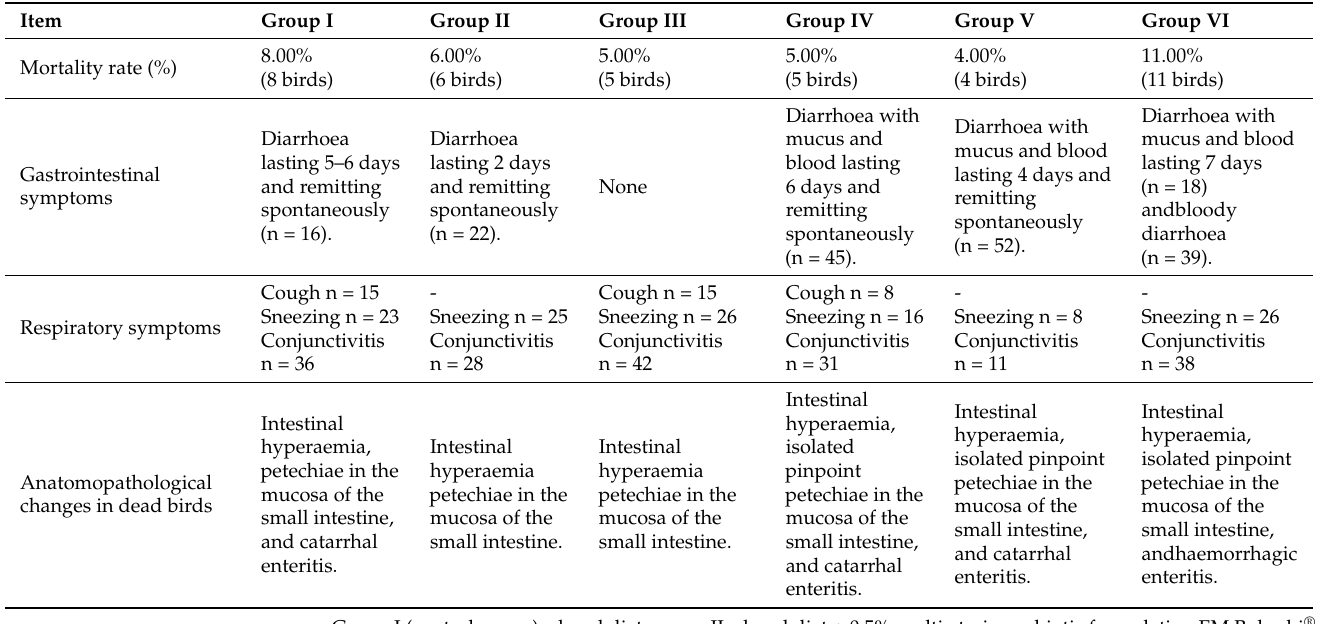
Table 4. Evaluation of health parameters.